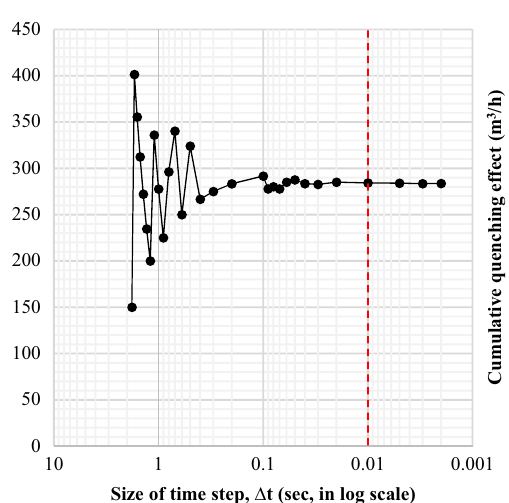
Figure 11. Improvement of the FEM convergence by reducing the time step